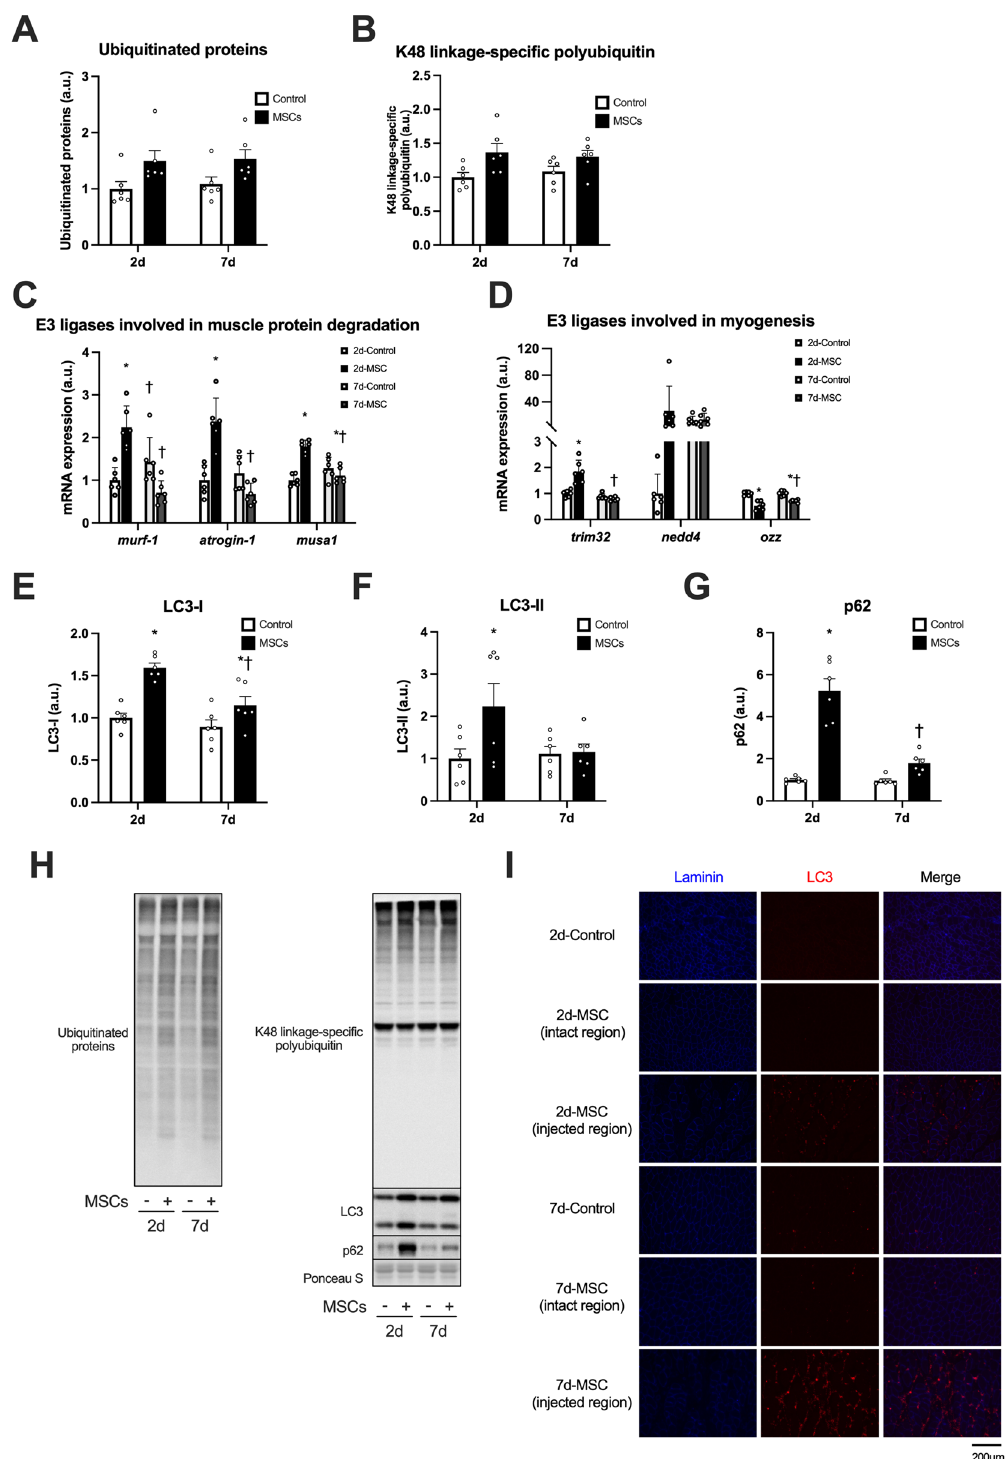
Figure 5. The expression of muscle catabolic systems-related factors after intramuscular injection of MSCs. Protein expression of ubiquitinated proteins ( A ) and K48 linkage-specific polyubiquitin ( B ), mRNA expression of E3 ligases involved in muscle protein degradation (MuRF-1, Atrogin-1, and MUSA1, C ), and involved in myogenesis (TRIM32, Nedd4, and Ozz, D ), protein expression of LC3-I ( E ), LC3-II ( F ), and p62 ( G ), representative bands ( H ), and cross-sections of muscle showing localization of laminin and LC3 ( I ). Data are expressed relative to the control leg at 2 days post intramuscular injection of MSCs as the mean ± SE. Significant main effects of MSC were observed in ubiquitinated proteins and K48 linkage-specific polyubiquitin (P < 0.0001 in both). * P < 0.05 vs Control and † P < 0.05 vs ipsilateral muscle at 2 days